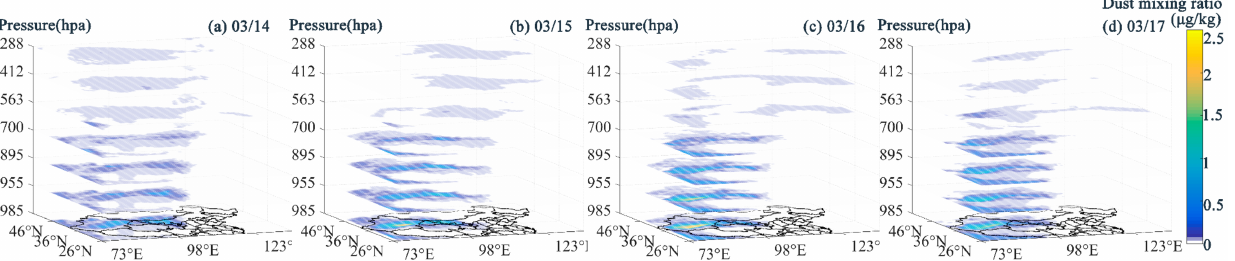
Figure 5. MERRA-2 dust mixing ratio during the 3.15